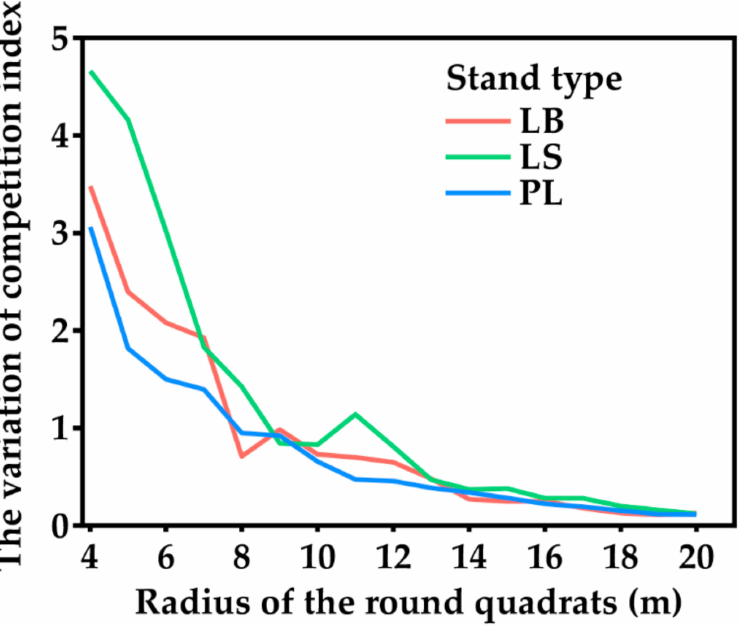
Figure 1. Relationship between the radius of the round quadrats and the variation in the competi- tion